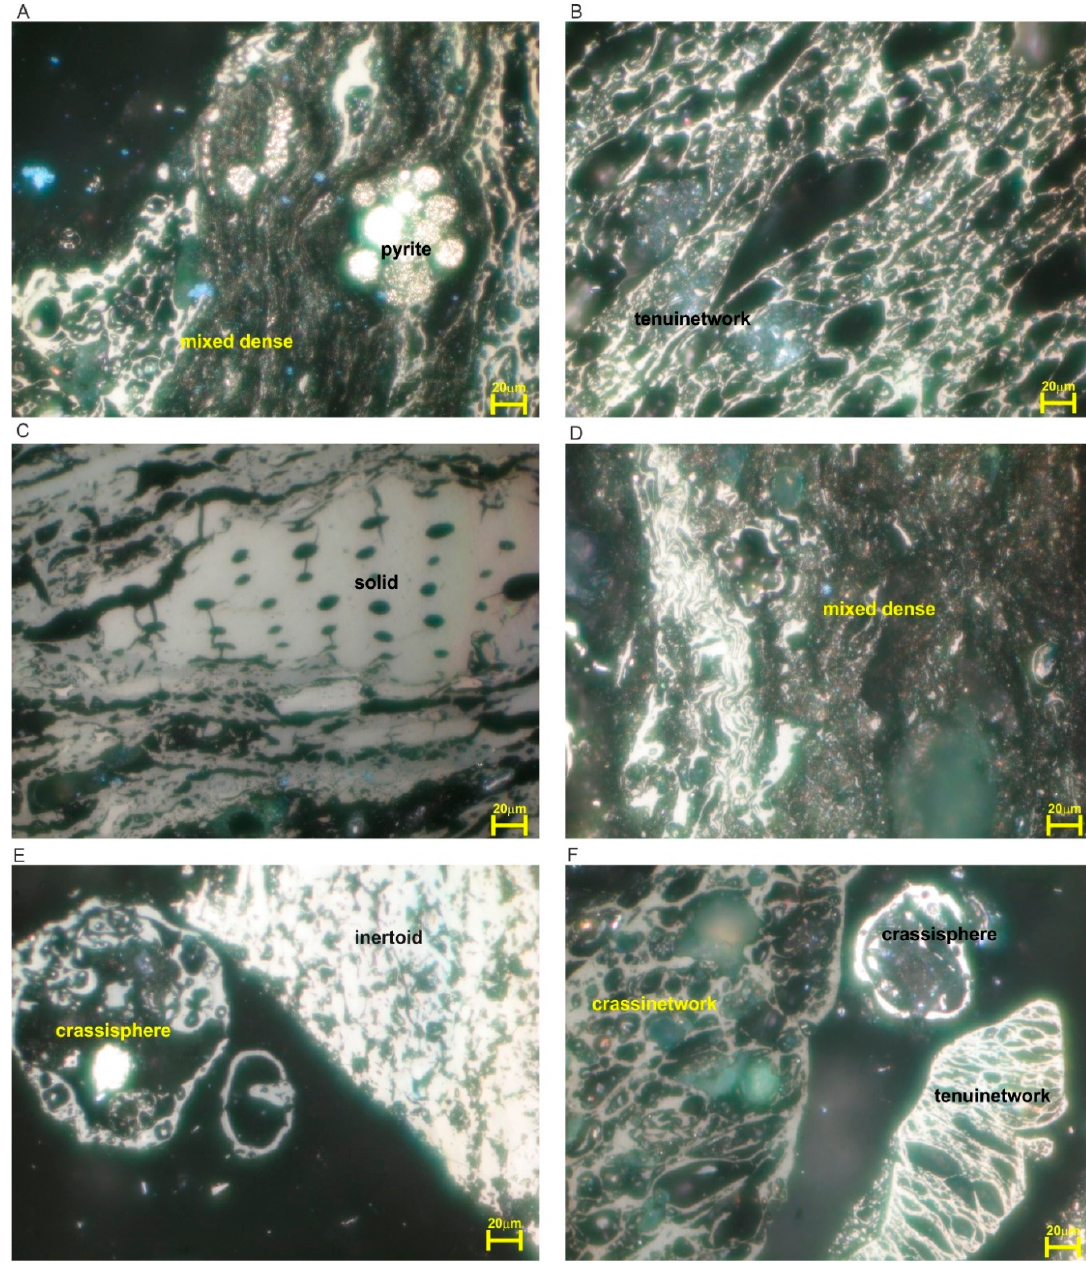
Figure 3. Gasification residue components after the gasification of coal from the Janina deposit: ( A ) Mixed dense with pyrite (bright, spherical), ( B ) tenuinetwork, ( C ) solid, ( D ) mixed dense, ( E ) inertoid (bright) and crassisphere, ( F ) crassinetwork (dark), crassisphere (spherical) and tenuinetwork. Reflected light, oil immersion.